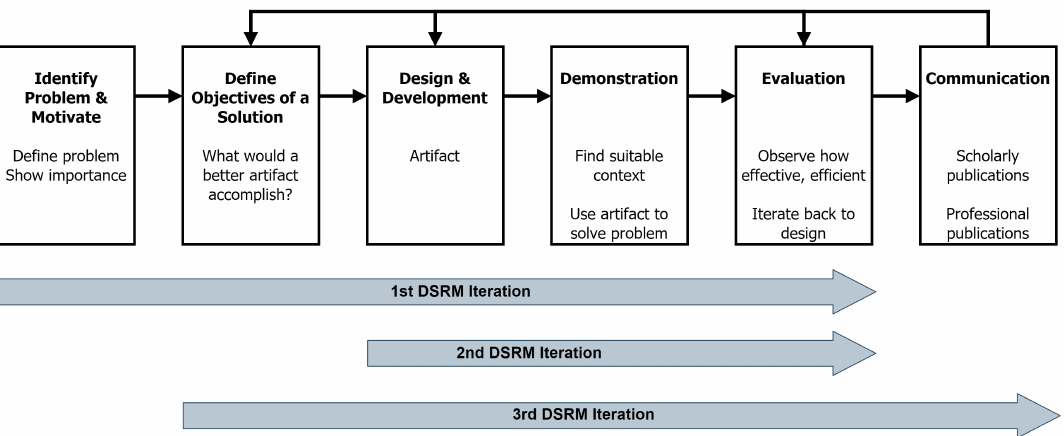
Figure 1. Iterations represented in the Design Science Research Methodology (DSRM) process model, Peffers et al.